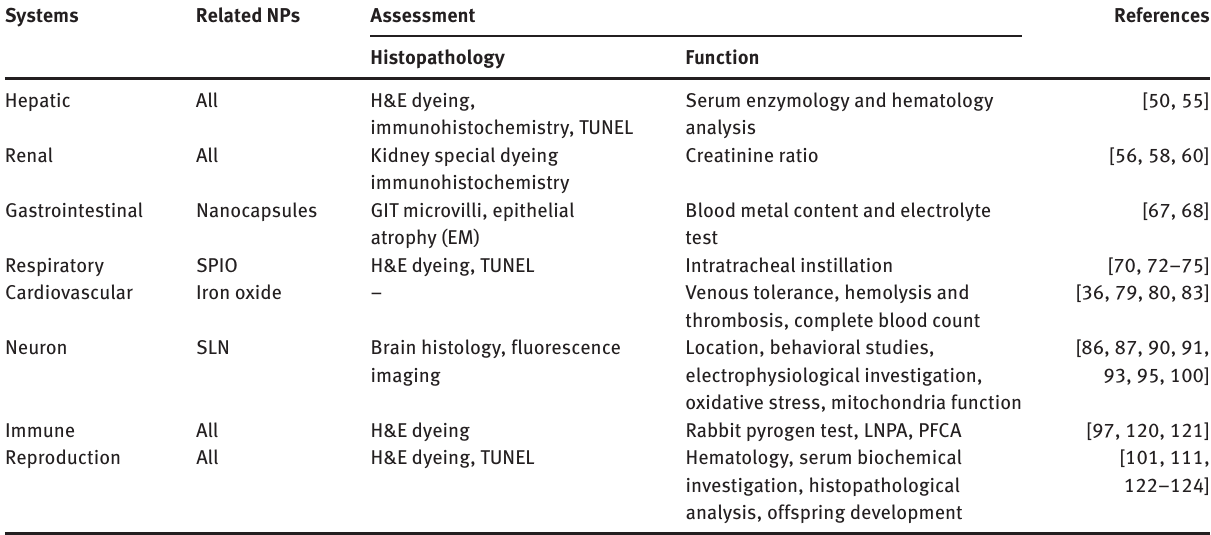
Table 2: Assessments of NP-related systems.